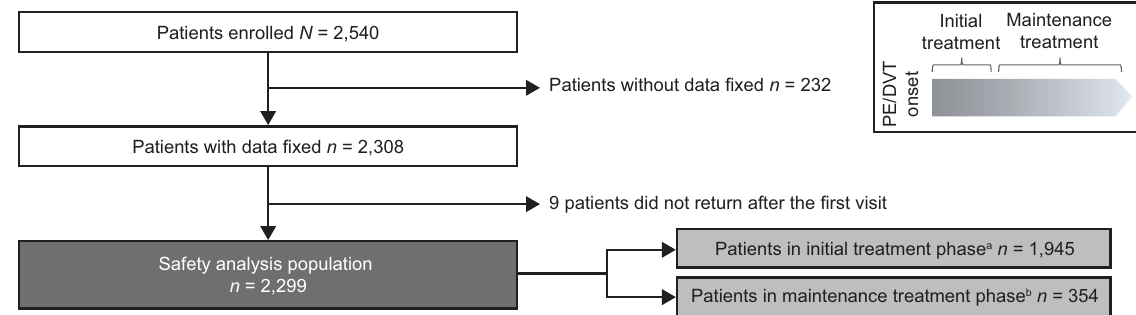
Fig. 2 Patient fl ow diagram. DVT, deep vein thrombosis; PE, pulmonary embolism. a Patients who were prescribed rivaroxaban for initial treatment. b Patients who were prescribed rivaroxaban for maintenance treatment (e.g., switching from other anticoagulants,